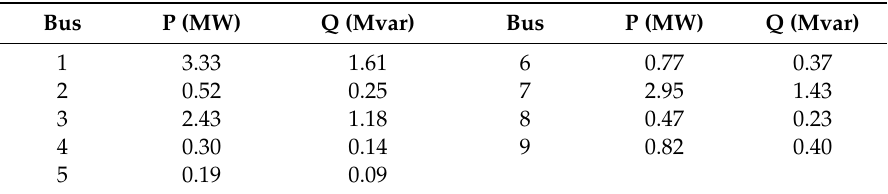
Table A1. Load data of the 24-bus distribution network at the reference